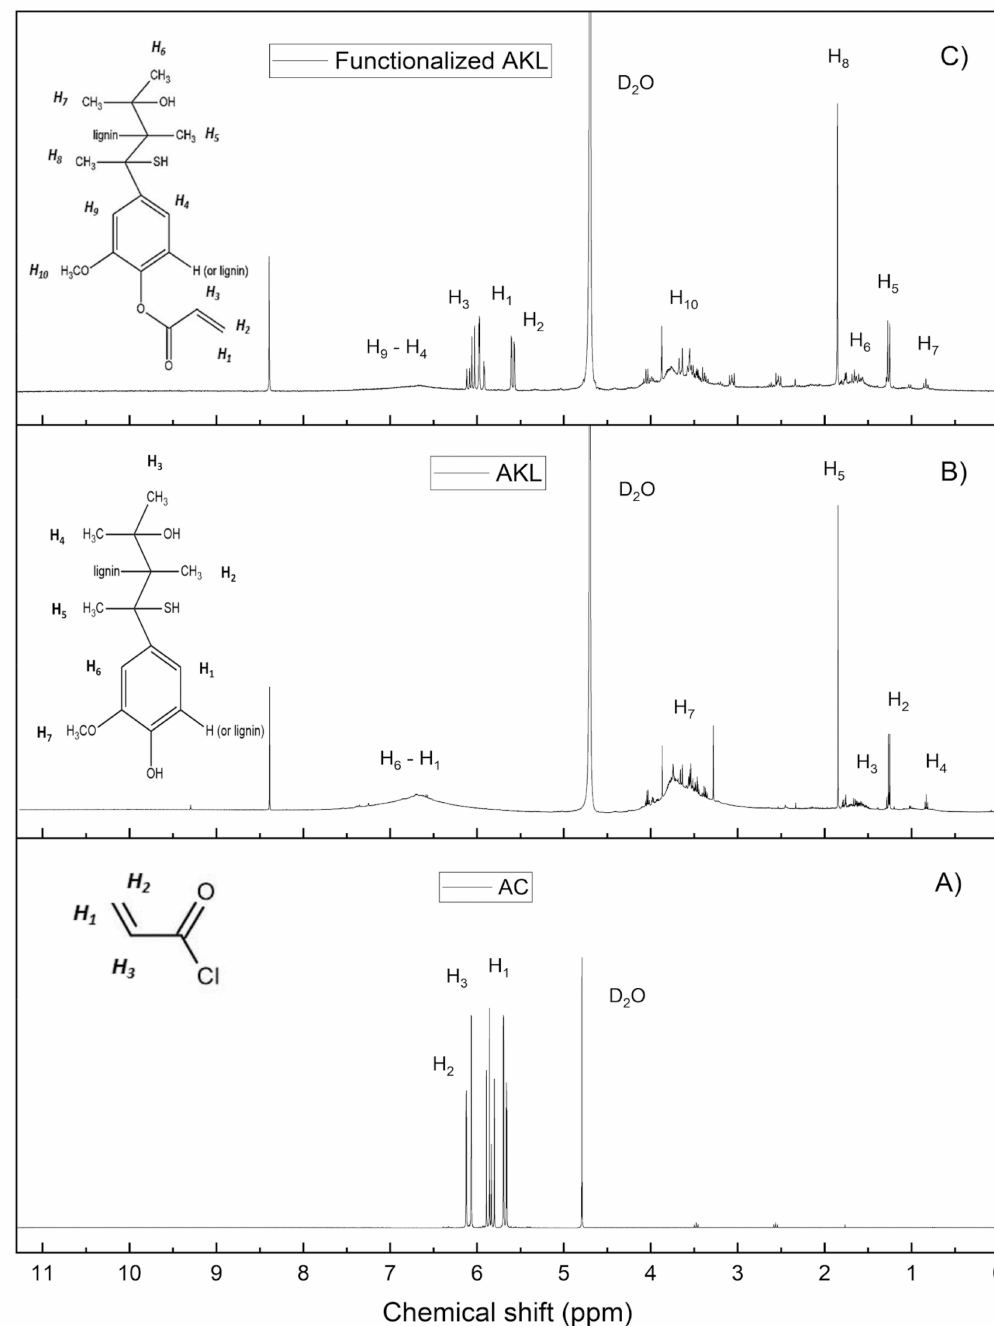
Figure 3. 1 H NMR analysis of acryloyl chloride ( A ), AKL ( B ) and functionalized AKL ( C